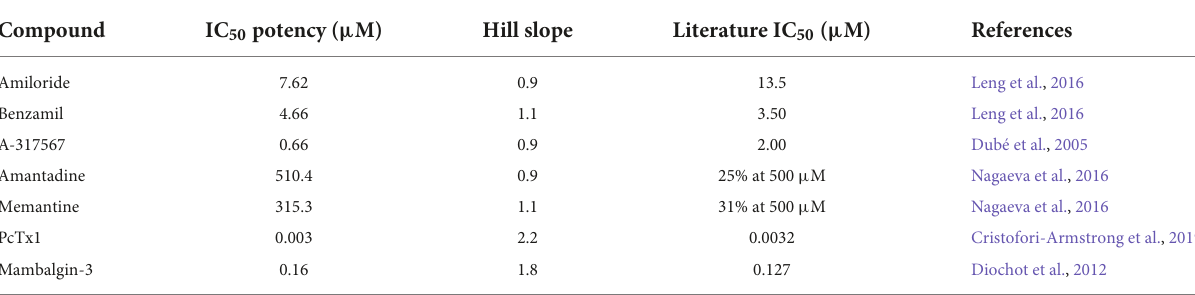
TABLE 2 ASIC1a pharmacology on QPatch